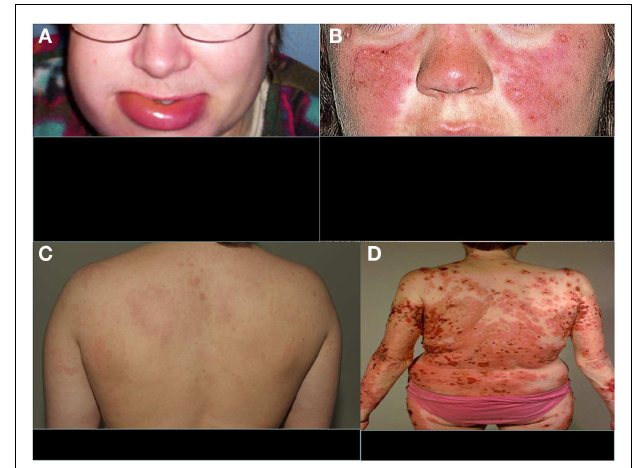
FIGURE 2 |Typical features of four distinct complement-related diseases with dermatological symptoms . (A) Hereditary angioedema, (B) SLE, (C) urticarial vasculitis, and (D) bullous pemphigoid. (A,C,D) are from the photogallery of the Clinic of Dermatology and Allergology, Helsinki University Central Hospital and (B) is from http://www.fightinglupus.org/sle-lupus.html